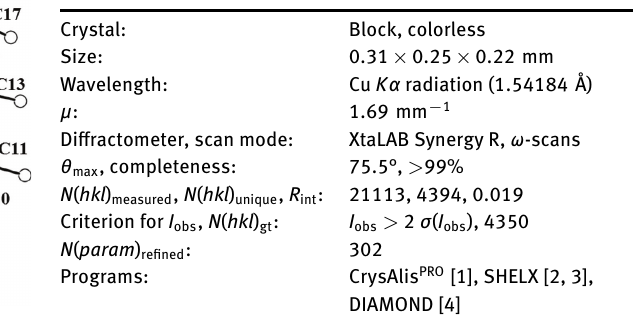
Table 1: Data collection and handling.